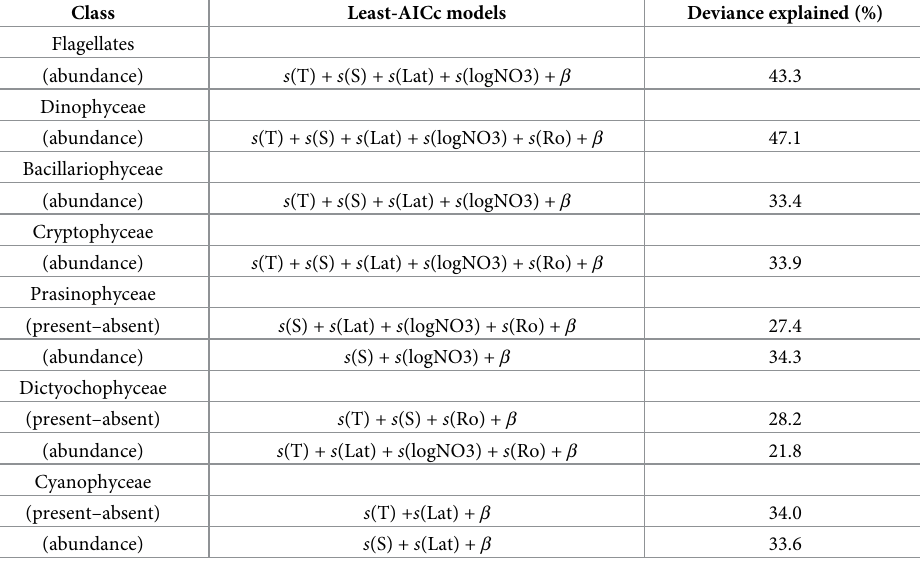
The s denotes the smoothing function, and T, S, Lat, logNO3, Ro, and β denote water temperature, sea salinity, latitude, common logarithm transformed nitrate concentration, relative vorticity, and intercept,